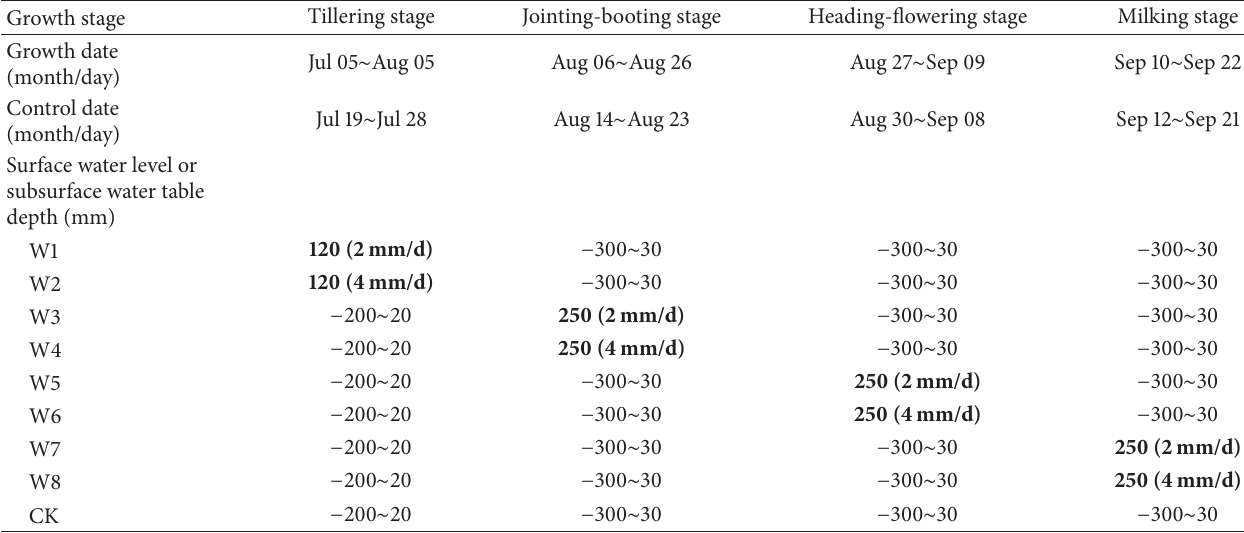
Figure 1: (a) Schematic diagram of irrigation-drainage system (IDS) and test-pits distribution. Water was supplied from an underground reservoir to every test-pit through pipelines. (b) Underground gallery and drainage system. (c) Lysimeter test-pits. Inside the yellow box is the electromagnetic flow valve device. Table 2: Design of PFCD water level and controlled periods in